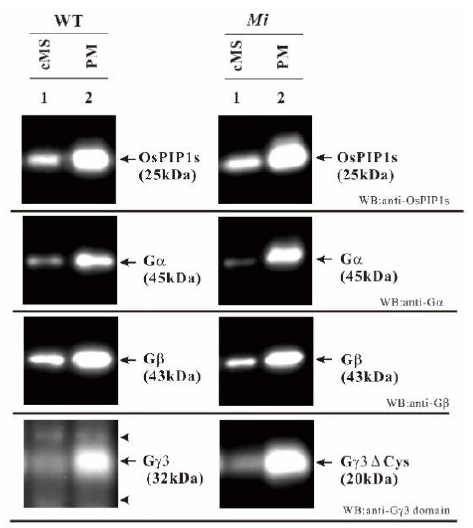
Figure 5. G γ 3 and G γ 3 ∆ Cys were enriched in the plasma membrane fraction of the wild-type (WT) and Minute ( Mi ) flowers. First 10 µ g of both the crude microsomal fraction protein and plasma membrane fraction protein from the WT and Mi were analyzed by western blot using anti-OsPIP1s, anti-G α , anti-G β , and anti-G γ 3 domain antibodies. OsPIP1s is an aquaporin, which is a plasma membrane marker. OsPIP1s (25 kDa), G α (45 kDa), G β (4 3kDa), G γ 3 (32 kDa), and G γ 3 ∆ Cys (20 kDa) are indicated by arrows. Non-specific bands are indicated by arrow heads.